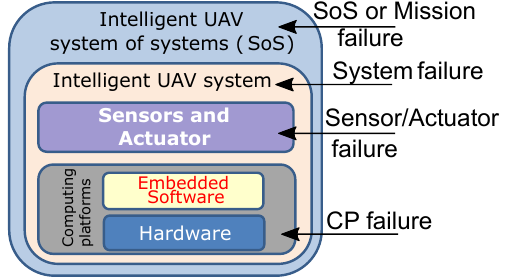
Figure 5. Different system layers and possible failures.